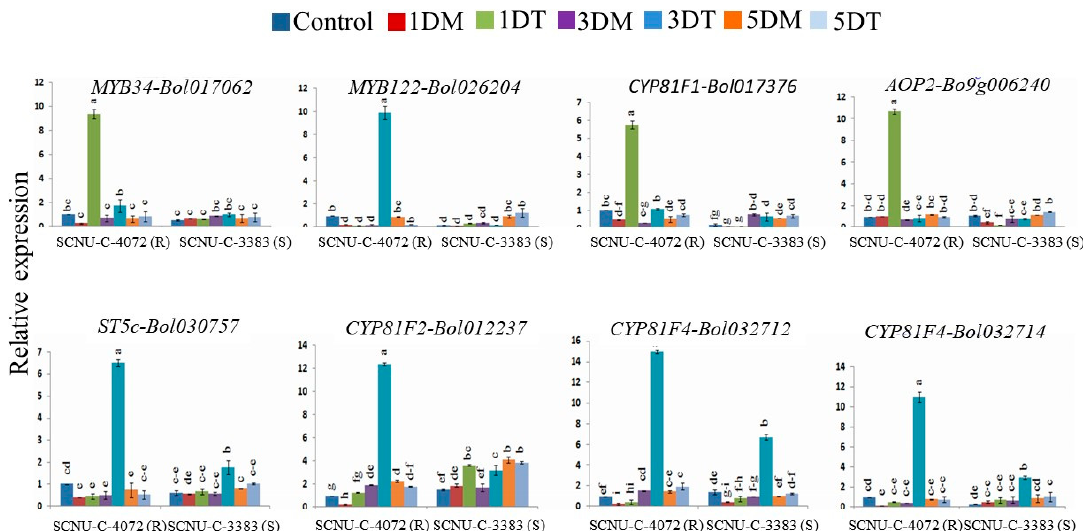
Figure 4. Relative expression of transcription factor-related genes and GSL biosynthesis genes in the black rot resistant (SCNU-C-4072) line at different days after inoculation (1, 3, and 5 DAI) using Xcc pathogen under different treatment conditions (C, control; 1DM, 1 day mock; 1DT, 1 day treated; 3DM, 3 day mock; 3DT, 3 day treated; 5DM, 5 day mock; 5DT, 5 day treated) compared to mock-treated